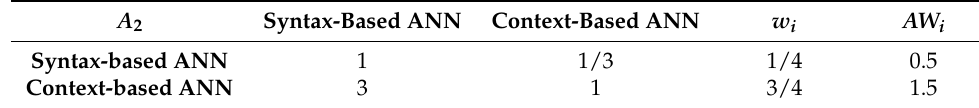
Table 5. The Proportion Of A 2 In The Strategies.